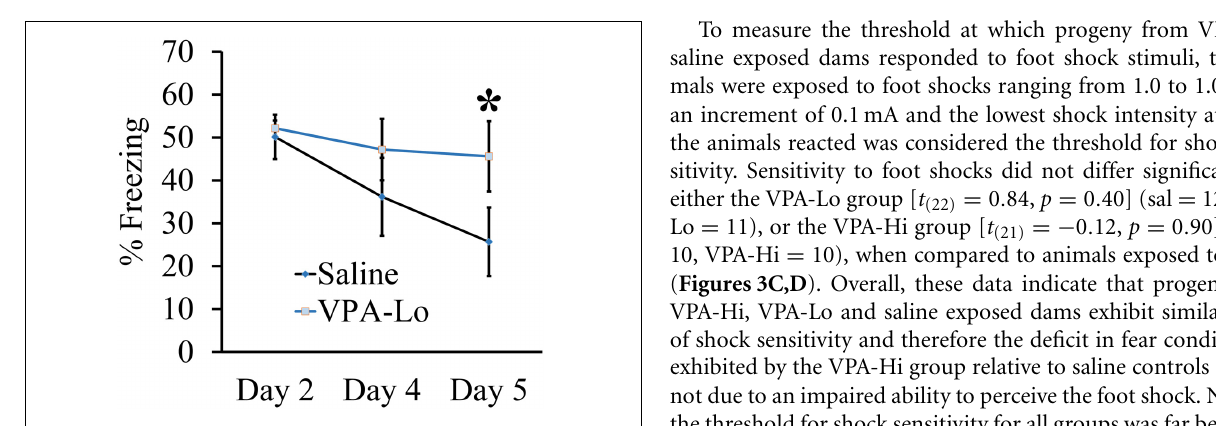
VPA-Lo = 10) (D) or progeny from VPA-Hi and saline exposed dams (Saline = 12, VPA-Lo = 11). (E) The primary auditory cortex response strength and response latency to a 5kHz tone did not differ between progeny from VPA-Hi and saline exposed dams (Saline = 10, VPA-Hi = 10). (F) Hearing ability to a 5kHz, 0–75dB tone did not differ between progeny from VPA-Hi and saline exposed dams (Saline = 10, VPA-Hi = 10) as measured by auditory cortex neuronal spike firing upon exposure to 5kHz, 0–75dB tones. Data presented as mean ±